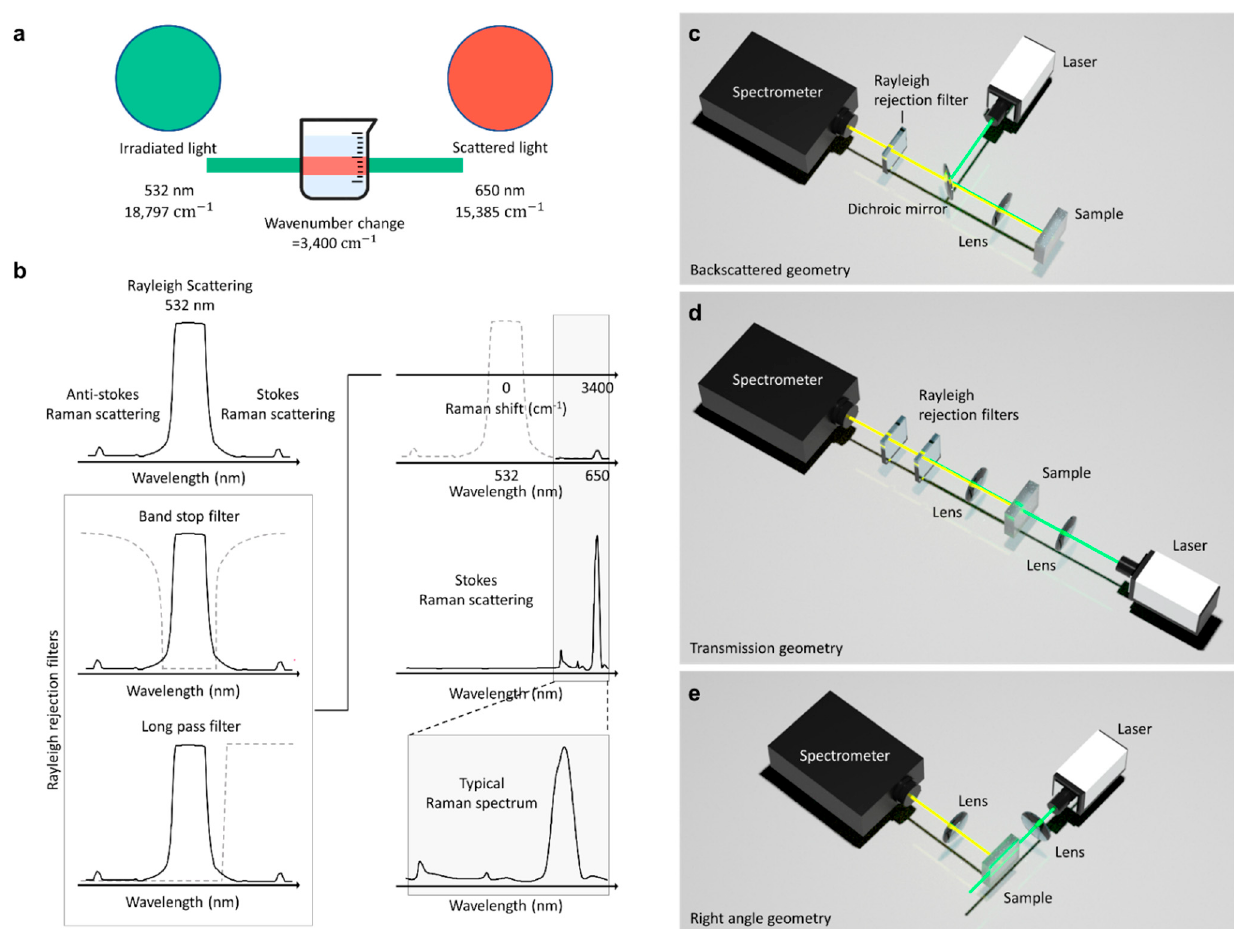
Figure 5. Features of Raman spectroscopy. ( a ) Schematic representation of the Raman shift from light scattering. It can be observed that an incident monochromatic laser with a wavenumber of 18,797 cm − 1 is scattered at a wavenumber of 15,385 cm − 1 . The resulting wavenumber change of 3400 cm − 1 is due to the vibrational energy changes of the molecules. ( b ) Effect of long-pass and band- pass filters on generated signals. Recorded signals from light scattering are generated by anti-Stokes Raman scattering, Stokes Raman scattering, and Rayleigh scattering. Rejection filters are required to eliminate Rayleigh signals. They work by allowing and attenuating signals at specified frequencies to measure Raman spectra. Collection geometries in Raman spectroscopy: ( c ) Backscattered geometry, ( d ) Transmission geometry, and ( e ) Right-angle geometry. Backscattered and Transmission geometries require Rayleigh rejection filters to eliminate the noise resulting from Rayleigh scattering and back- reflected excitation light. Unlike the former two geometries, the configuration of right-angle geometry yields little noise, and, hence, rejection filters are not